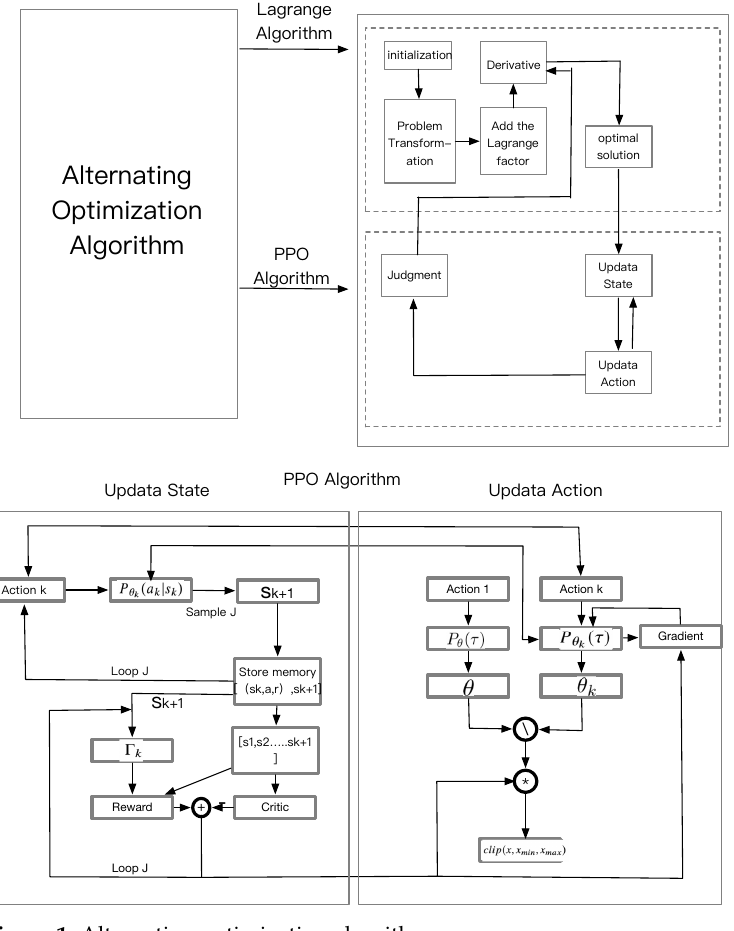
Figure 1. Alternating optimization algorithm. Table 1. Our novel contribution contrasted to the state-of-the-art in UAV communication